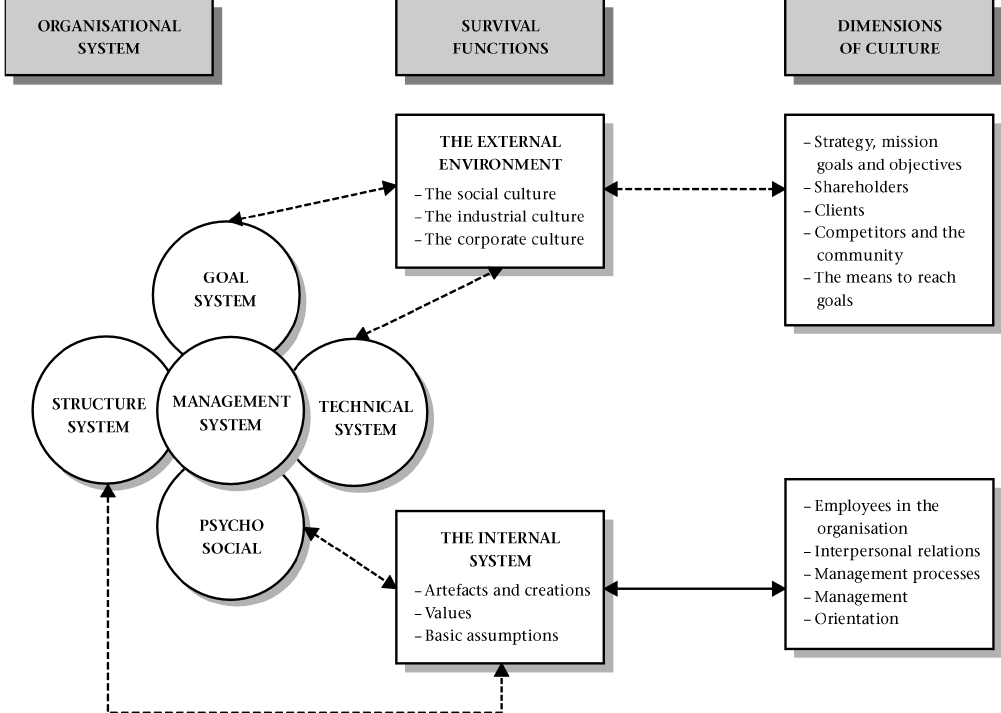
Figure 2: A Model of Organisational Culture (Martins, 1989,